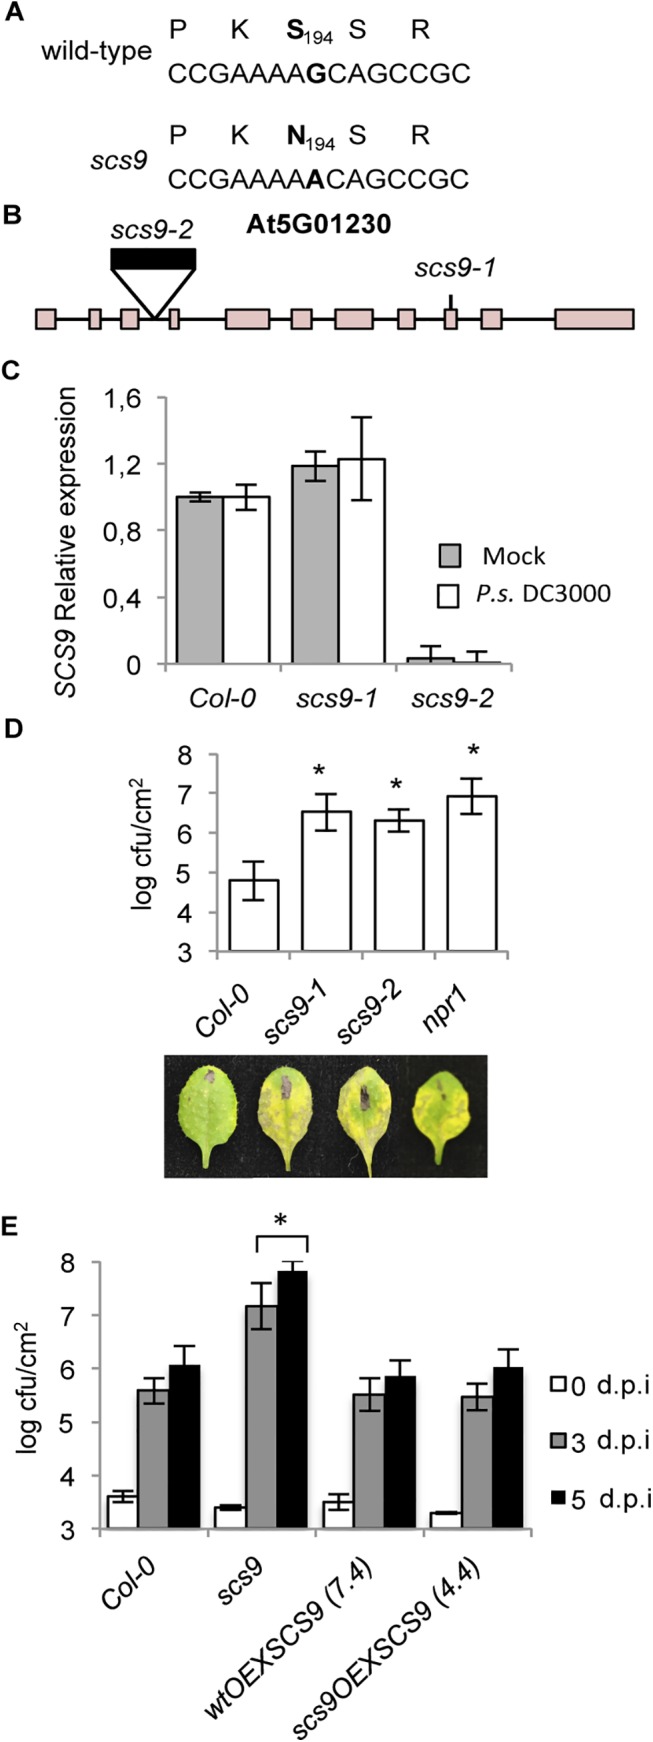

scs9 is a mutant allele of At5g01230.(A) SCS9 corresponds to At5g01230. The G nucleotide residue mutated to an A nucleotide in the scs9 allele is indicated in bold letters. The deduced amino acid sequences are indicated above each nucleotide sequence, and the deduced amino acid change (S194 to N194) is shown in bold. (B) Intron-exon arrangement in At5g01230. Exons are shown as boxes. The distances are only approximate. Position of a T-DNA insertion in the third intron (indicated by a black box) and localization of the EMS-induced mutation in the 9th exon, rendering scs9-2 and scs9-1 mutant alleles, are indicated. (C) RT-qPCR analysis of the SCS9 transcript accumulation levels in mock- and P.s. DC3000-inoculated Col-0, scs9-1, and scs9-2 plants at 3 d.p.i. Data represent the mean ± SD; n = 3 replicates. (D) Comparative growth of P.s. DC3000 in Col-0, scs9-1, scs9-2, and npr1 plants 3 d.p.i. Error bars represent SD (n = 12). Below are representatives of inoculated leaves of the indicated genotypes. (E) SCS9 overexpression complements the scs9-1 mutant and bacterial growth titers reach Col-0 levels. Plants of the indicated genotype were inoculated with P.s. DC3000. Bacterial growth was measured zero (white bars), three (grey bars), and five (black bars) d.p.i. Error bars represent SD (n = 12). Asterisks indicate statistical differences compared with Col-0 (P<0.05) analyzed using a Student’s t-test.